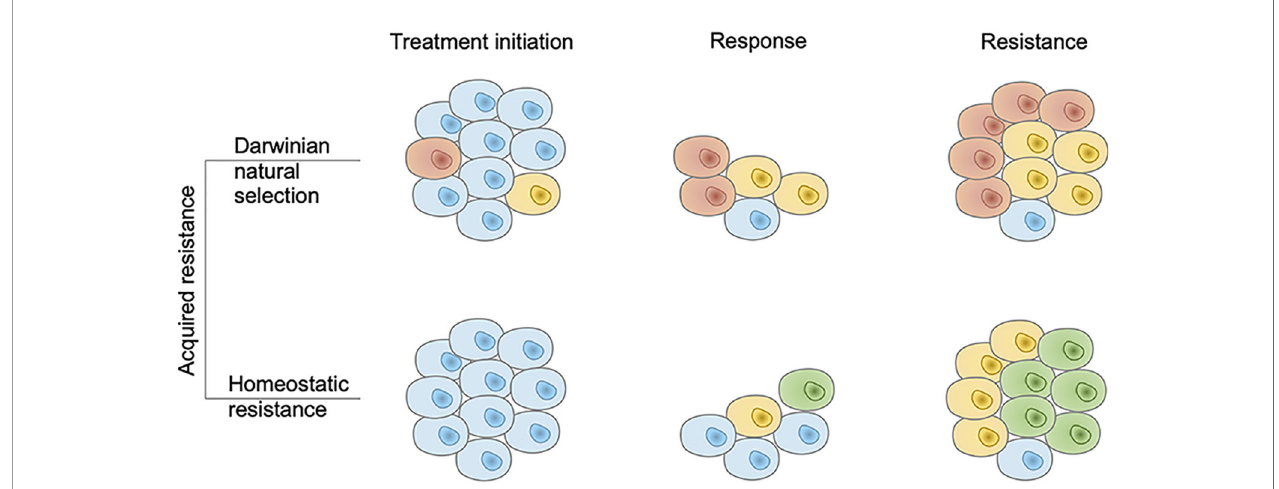
FIGURE 1 | Two modes of acquired resistance to immunotherapy. In the Darwinian natural selection mode, immunotherapy resistant tumor cell clones pre-exist in the tumor mass. They are present at the treatment initiation phase and resist the immune response. In the homeostatic resistance mode, resistant clones are not present before the treatment initiation but emerge under the additional immune pressure it generates. Brown, yellow, and green cells denote different resistant tumor cell clones and blue cells denote sensitive tumor cell